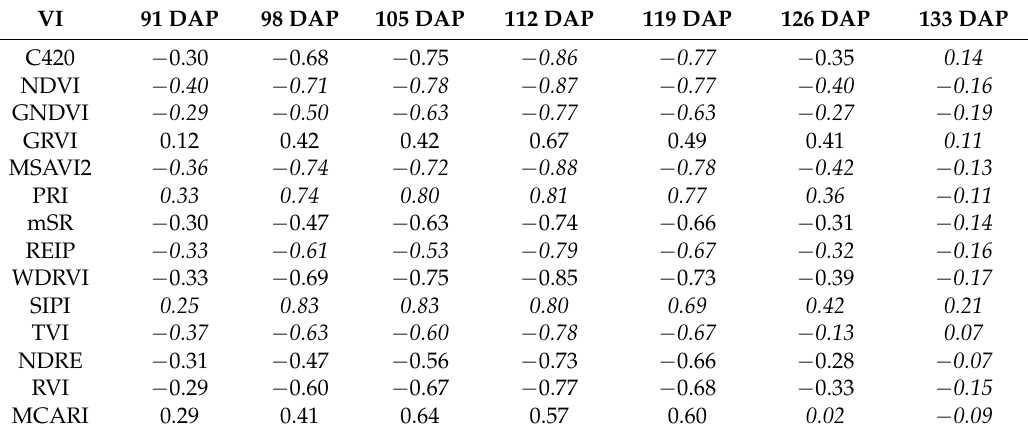
Table 5. Correlation between disease rating and vegetation indices, starting at Julian day 243, which is also 91 days after planting (DAP). Prior to this date, no disease symptoms were observed on plants. The highest five significant correlations are highlighted with bold and